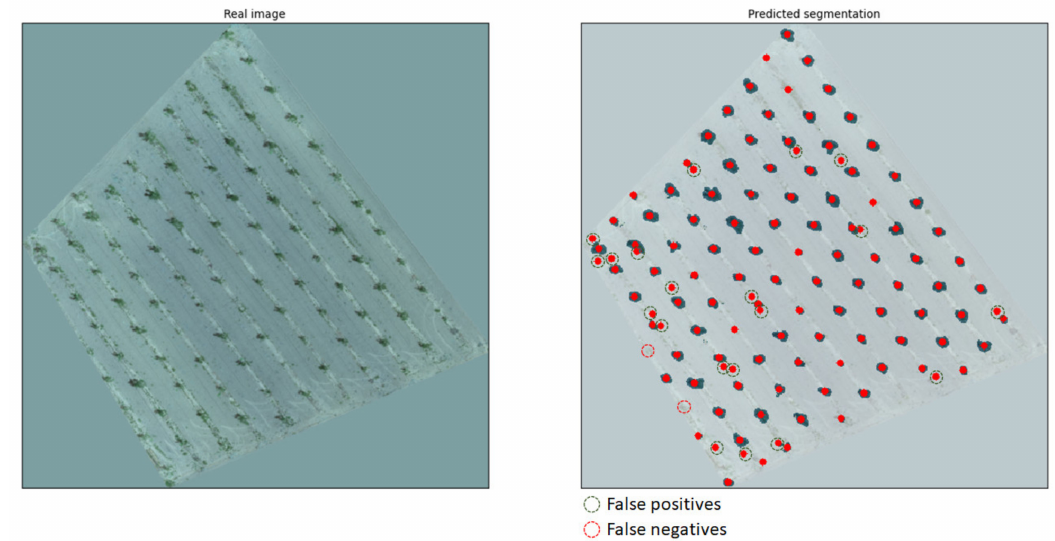
Figure 11. Complete orthomosaic of a study orchard with trees with small-sized canopies, not treated for weeds ( left ), and the segmentation predicted by the model ( right